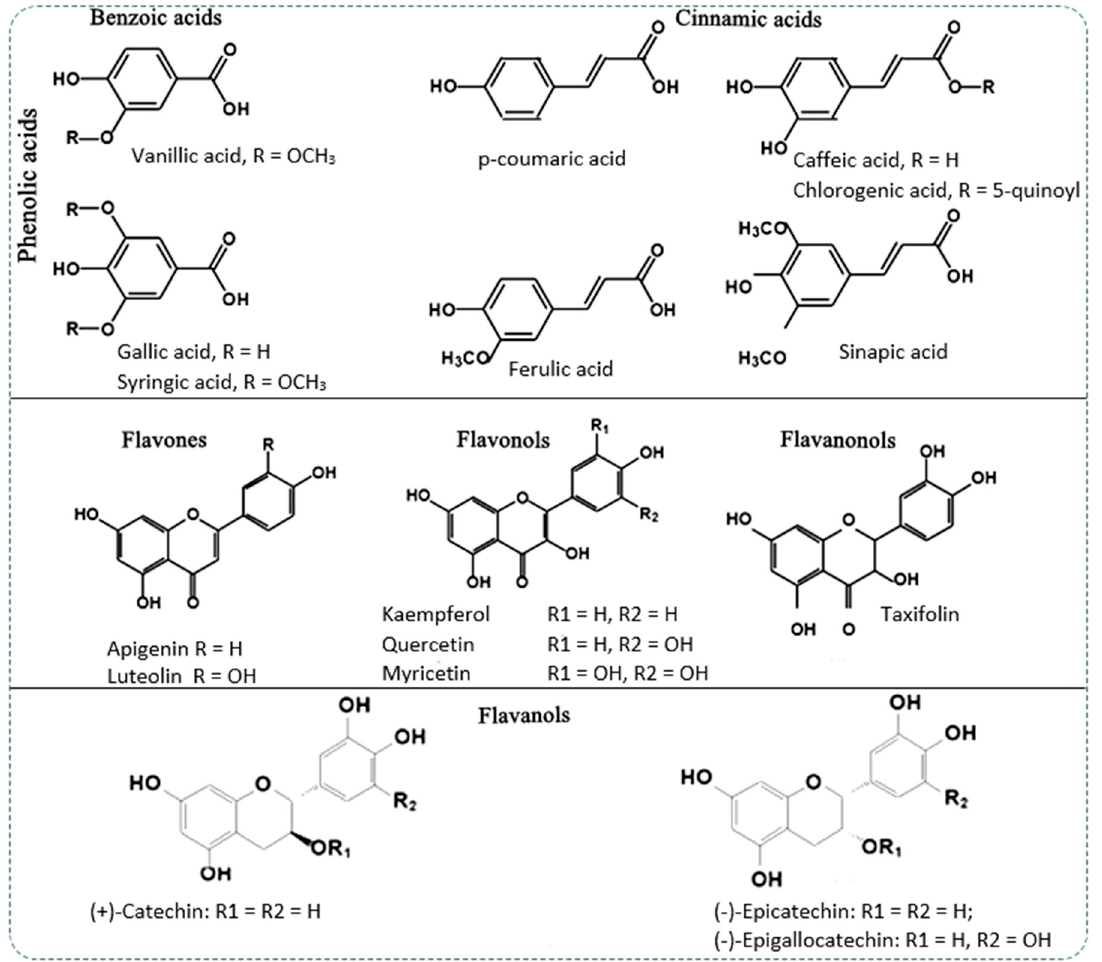
Figure 1. Typical phenolic compounds identified in the bark of woody vascular plants.